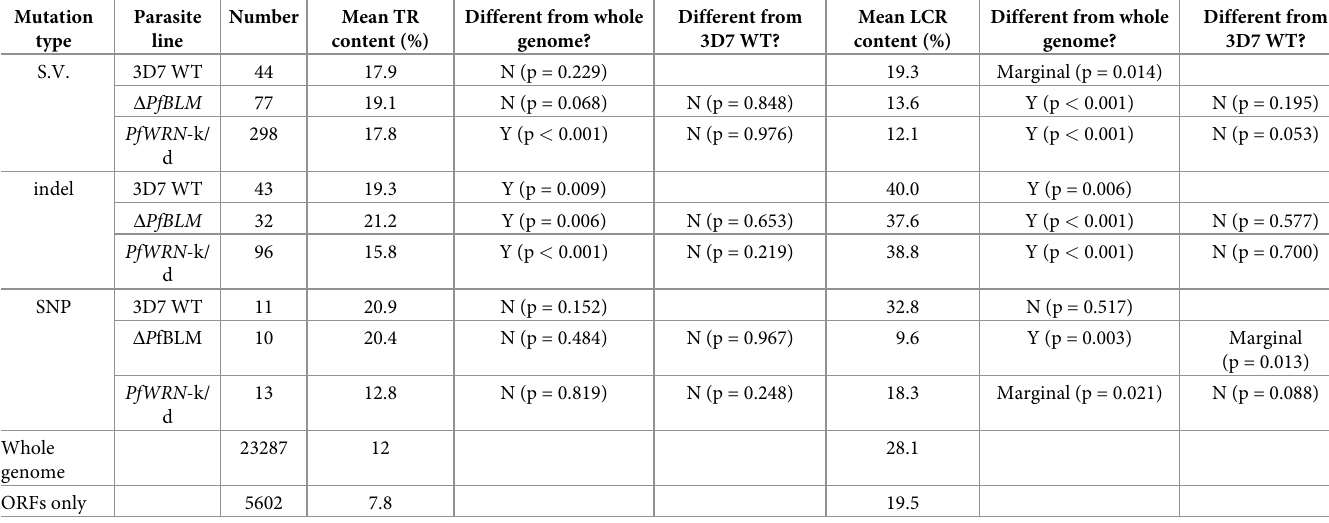
Table 2. Analysis of association between mutation events and tandem-repeat or low-complexity DNA regions.